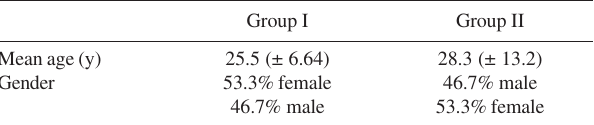
Table 1 - Patients’